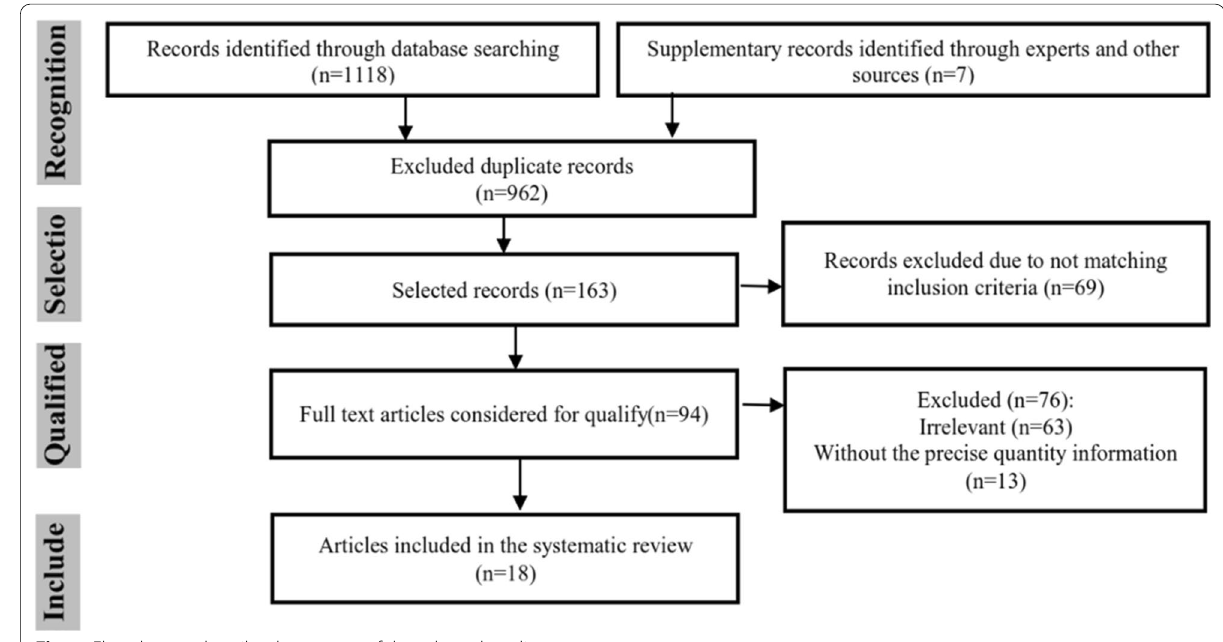
Fig. 1 Flowchart to describe the process of the selected